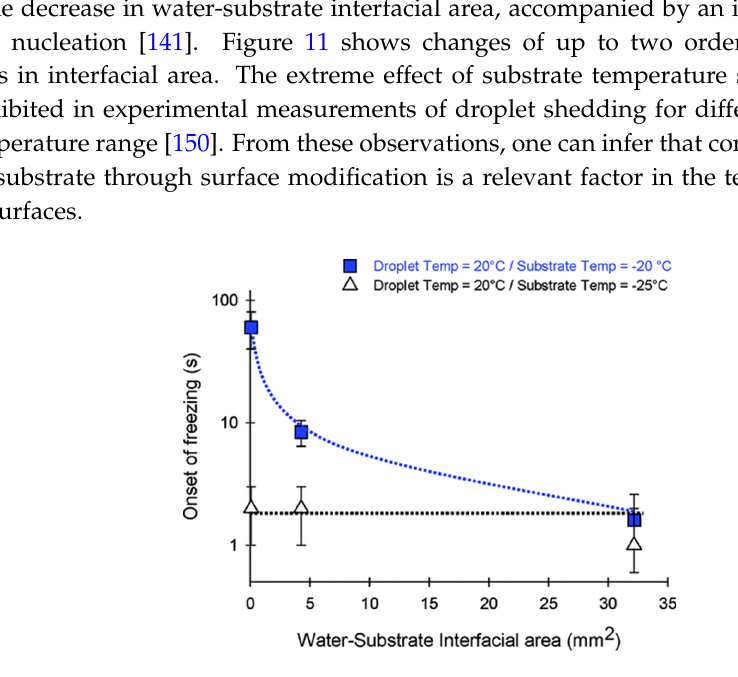
Figure 11. Freezing onset as a function of the interfacial area of contact between the substrate and the droplet for two different substrate temperatures. Reprinted with permission from Ref. [141]. c (cid:13) 2012 American Chemical